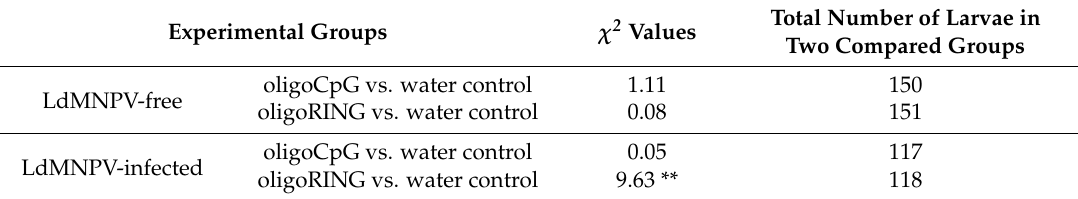
Statistical analysis of the insecticidal effect of oligoDNAs on LdMNPV-free and LdMNPV-infected gypsy moth larvae. Pearson’s chi-squared test ( χ 2 ) with Yates’s correction was used to evaluate the significant difference in larval death for each treatment (three replicates per treatment). χ 2 values were calculated for experimental groups versus water-treated control groups on the 14th day after the treatment. ** indicates significance when p <